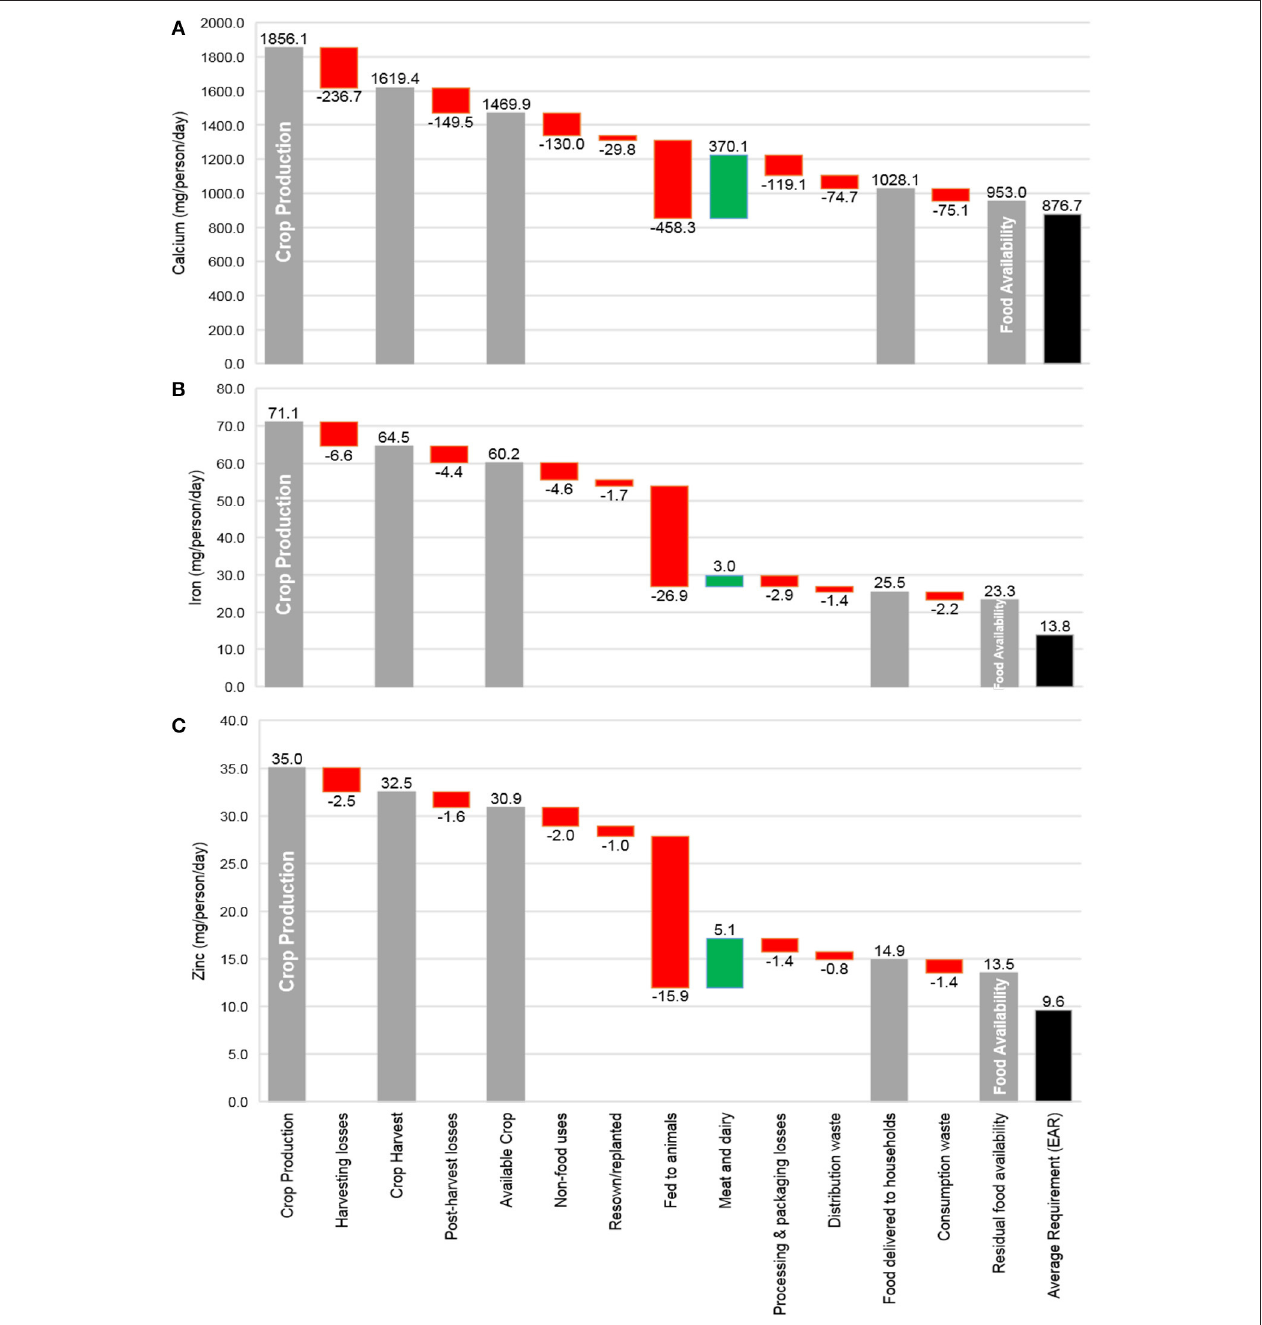
FIGURE 2 | Production and losses of micronutrients in the global food system from “field to fork” in 2011. Food pathways in (A) calcium; (B) iron; and (C) zinc from crop production to residual food availability, normalized to average per capita levels assuming equal distribution. Red bars (negative numbers) indicate food system losses; green bars indicate meat and dairy production; gray bars indicate macronutrient availability at intermediate stages of the chain, with the estimated average requirement shown in